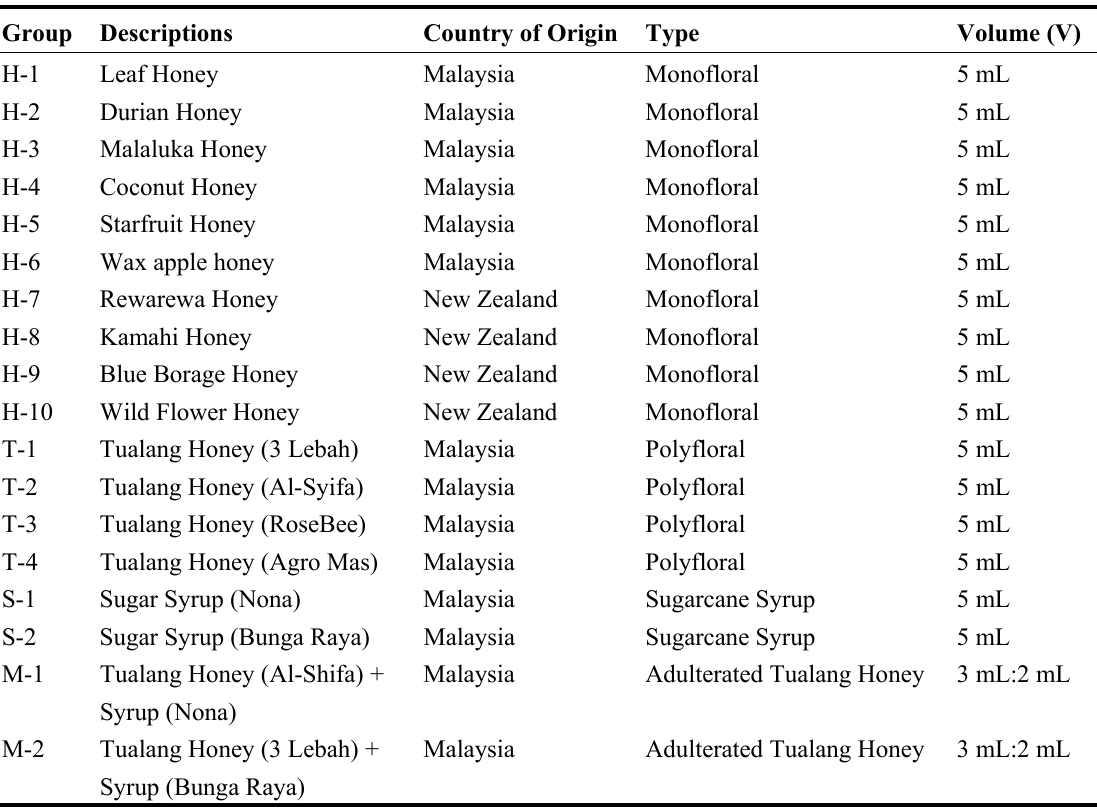
Table 1. Description of different samples variety of honey and syrup used in the experiments.